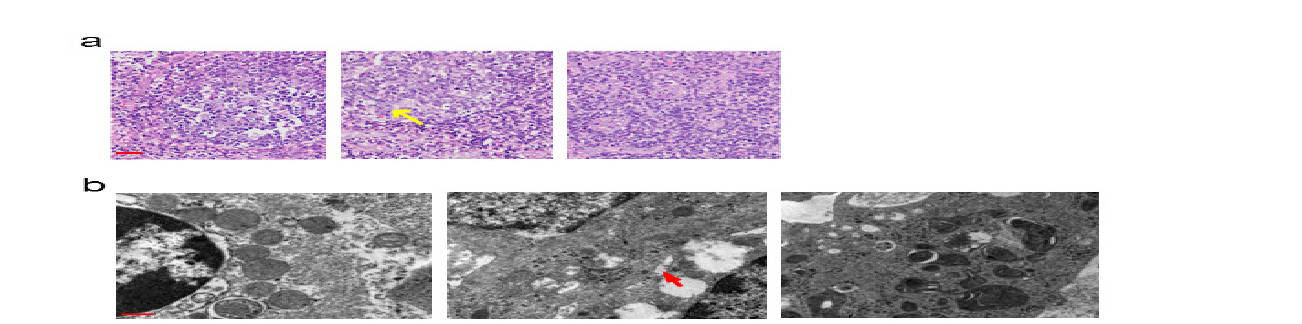
FIGURE 3 - AH treatment mitigated the pathological changes in GALTs. GALTs were sectioned and observed under the light microscope (magnification ×200, scale bar = 20 µm). The yellow arrow showed the phagocytosis in the reaction center (a). Ultrastructure was observed by TEM (magnification ×200, scale bar = 0.5 µm). The red arrow showed the damage of mitochondria